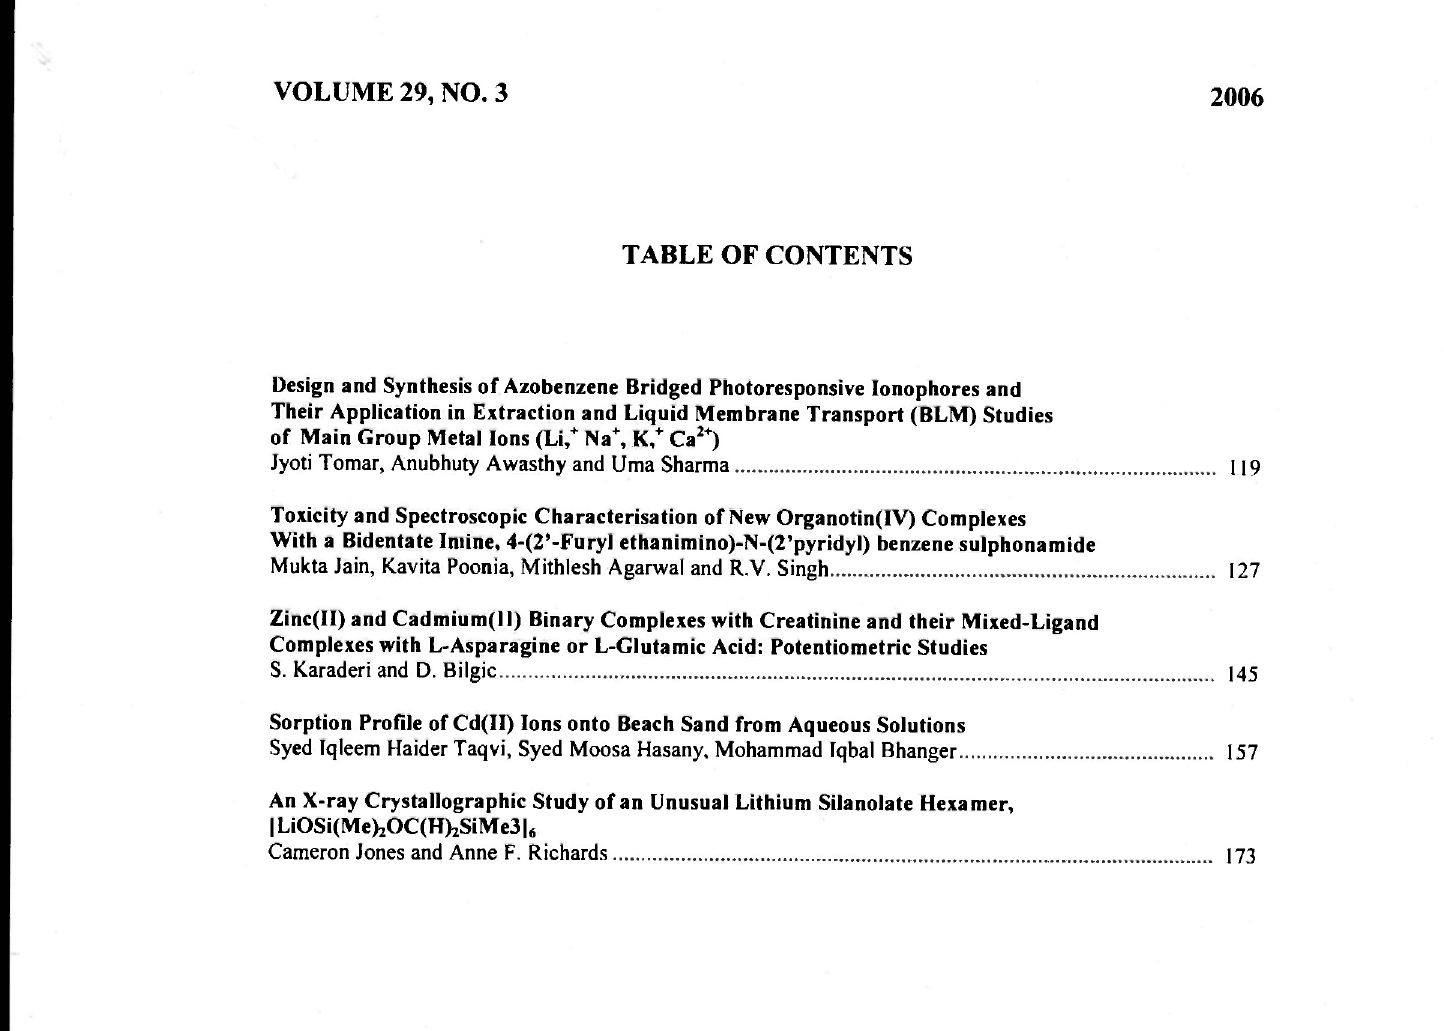
An X-ray Crystallographic Study of an Unusual Lithium Silanolate